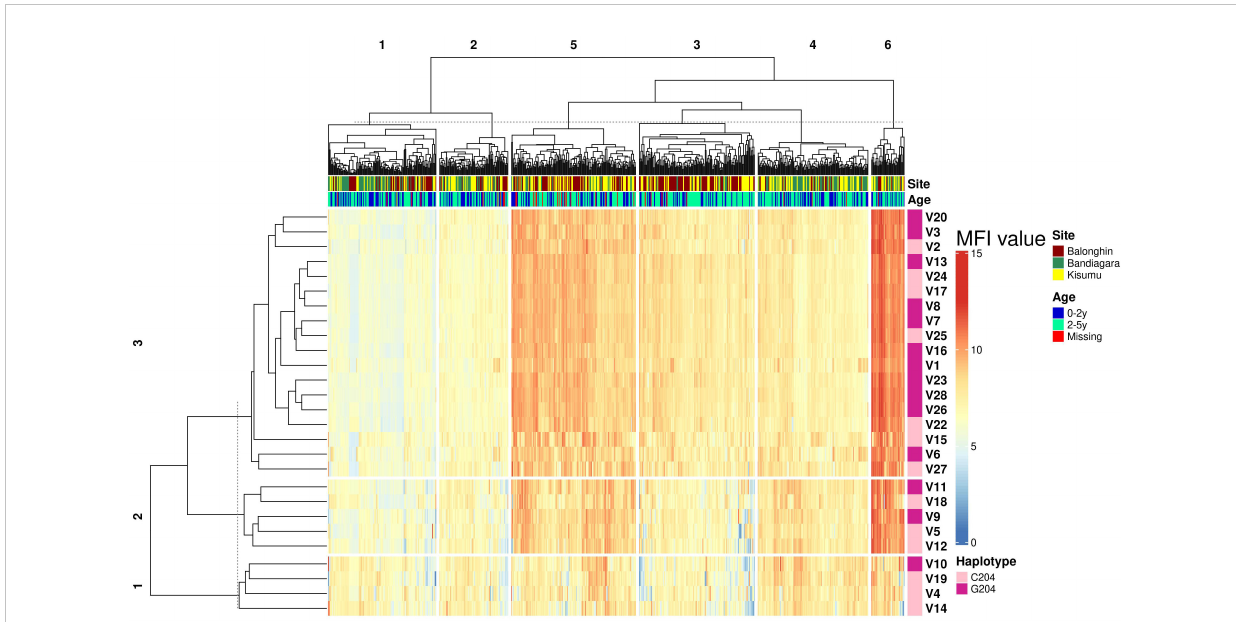
FIGURE 4 Geographical location is the main determinant of ARMA serogroup. Heatmap combines hierarchical cluster analysis of Spearman ’ s R (dendrogram on y axis, left) of individual antibody response measurements (MFI values) by geographical location and age group with haplotype diversity (y axis, right). Numbers above dendrograms indicate the ranks of the clusters. C204 and G204 are the two haplotype families of ARMA. Malaria status indicates whether or not a child developed clinical malaria during follow